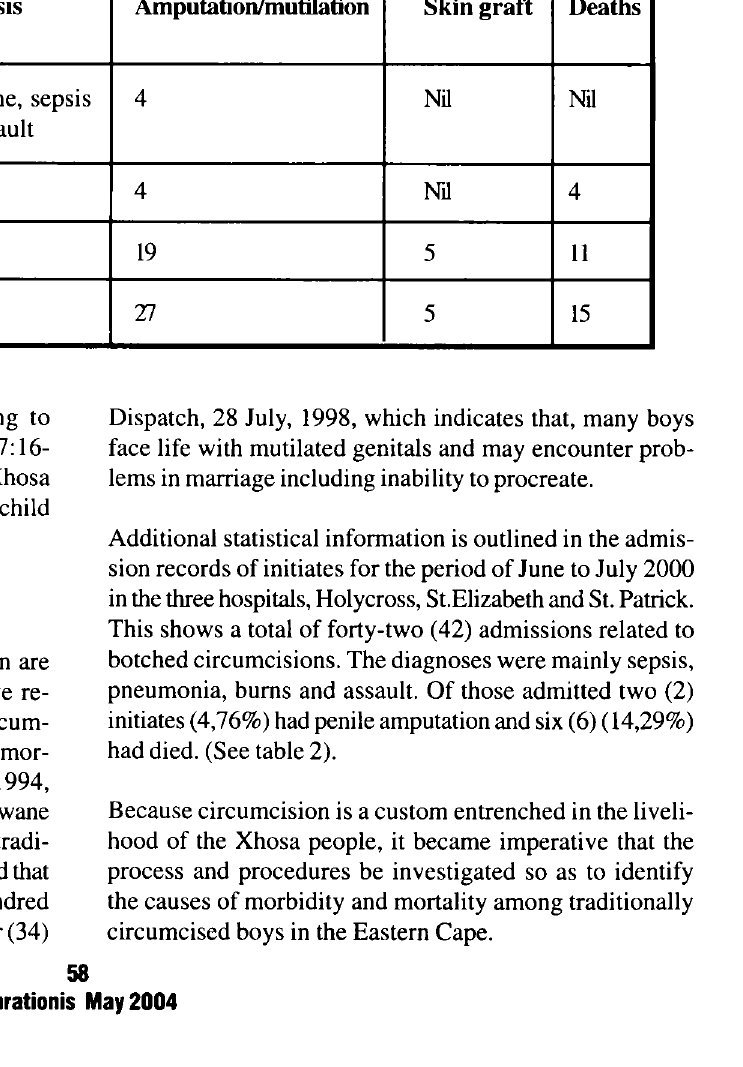
Table 1: Flagstaff district circumcision report 1996-1998 Sub-district No. of